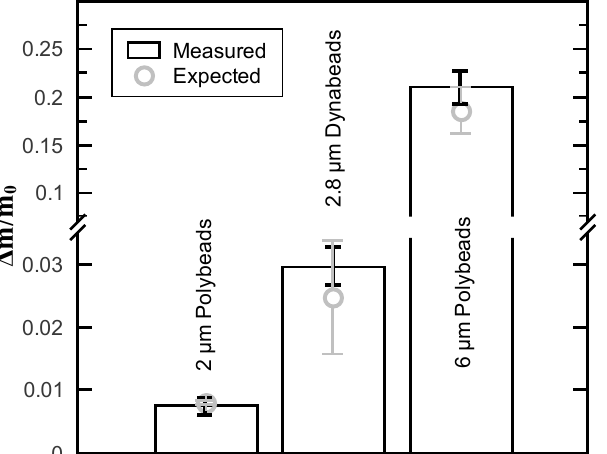
Figure 3. The average mass ratio Equation(8) for the three different types of micro particles compared to the expected values. For the string mass calculation a mass density for silicon nitride of ρ = 3 , 000 kg/m 3 was assumed. The black error bars represent the standard deviation of the different measurements. The gray error bars represent the error coming from the particle diameter